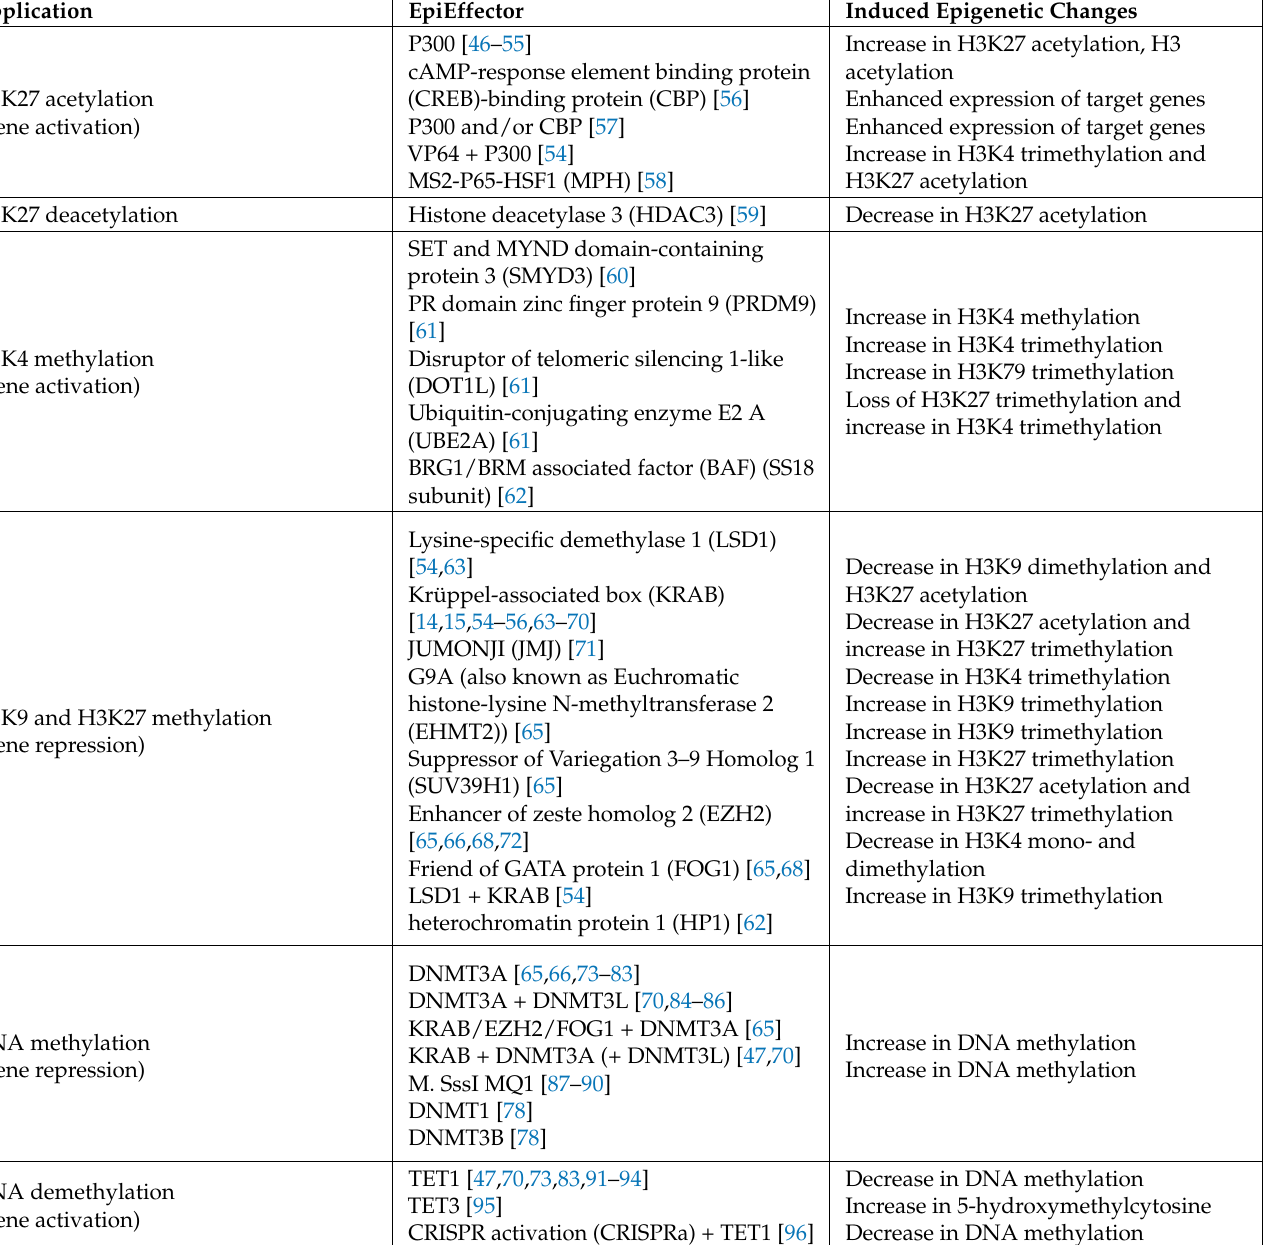
Table 1. Summary of EpiEffectors and their induced